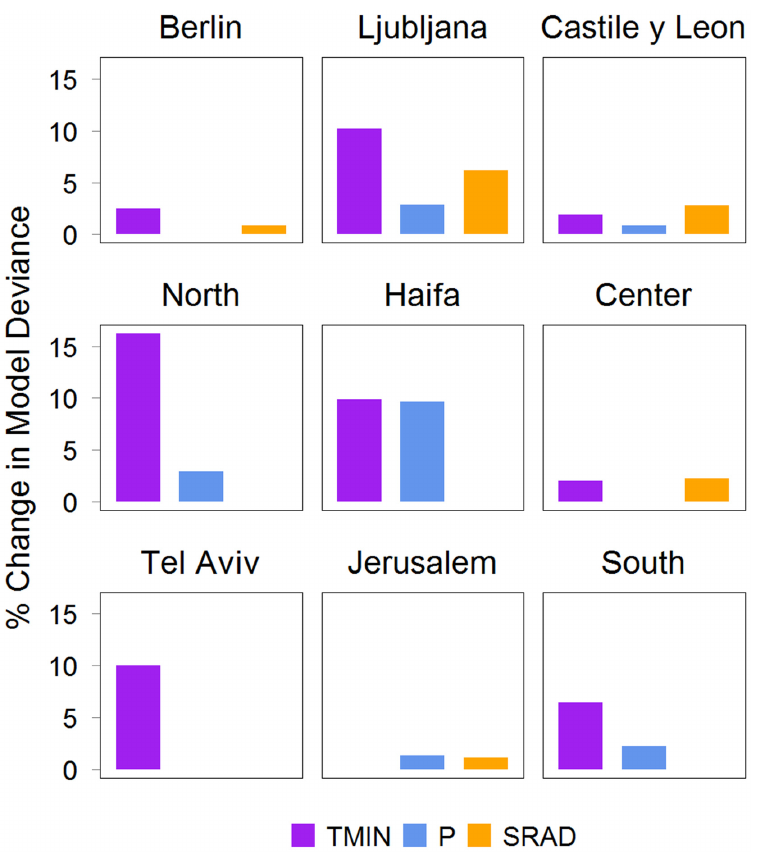
Fig 6. Percentage change in model deviance when the specified meteorological parameter was excluded from Model 2. TMIN is minimum temperature, PRCP is precipitation and SR is solar radiation.